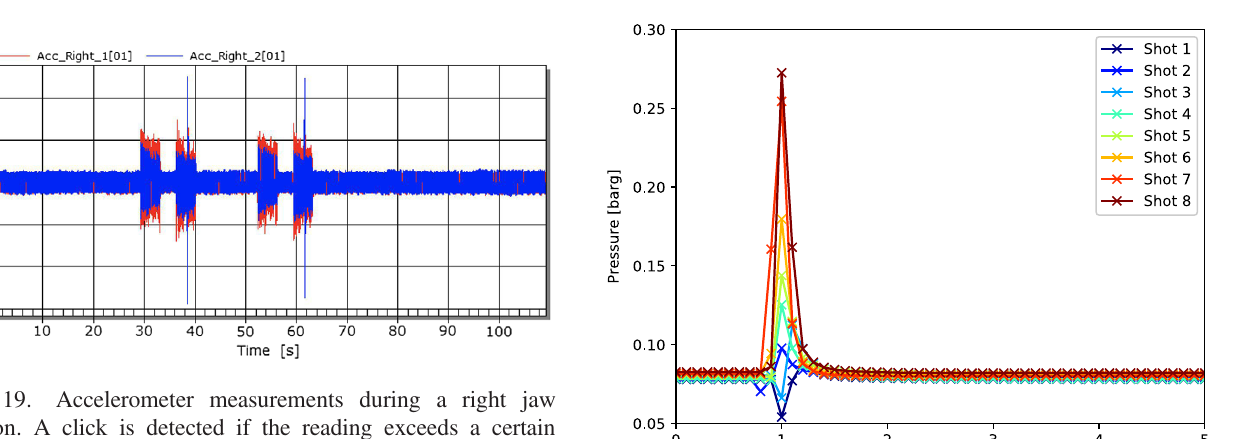
FIG. 18. Comparison of the left and right jaw alignments before and after shot 6 (pulse 192), showing the effect of the subsequent debris on the measured jaw positions.